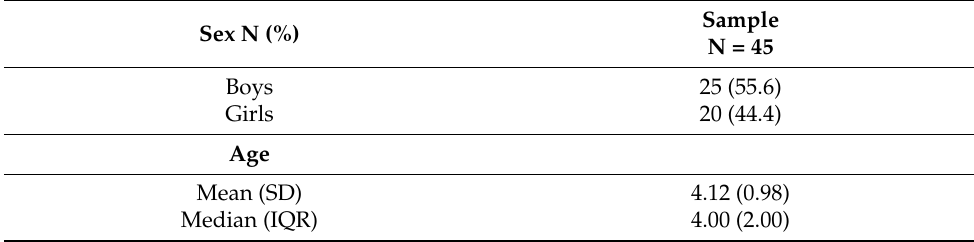
Table 1. Demographic characteristics of the sample.